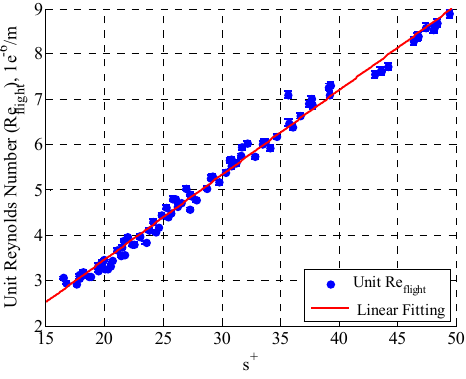
Figure 2. Relationship between s + and unit Reynolds number.